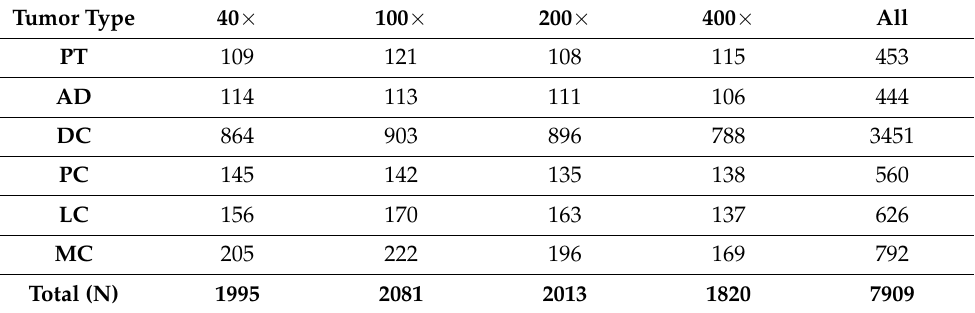
Table 1. Number of images at 40×, 100×, 200×, and 400× magnification factors from BreaKHis dataset stratified with respect to cancer subtype. FA: fibroadenoma, TA: tubular adenoma, PT: phyllodes tumor, AD: adenosis, DC: ductal carcinoma, LC: lobular carcinoma, MC: mucinous carcinoma, PC: papillary carcinoma, N: number of images.